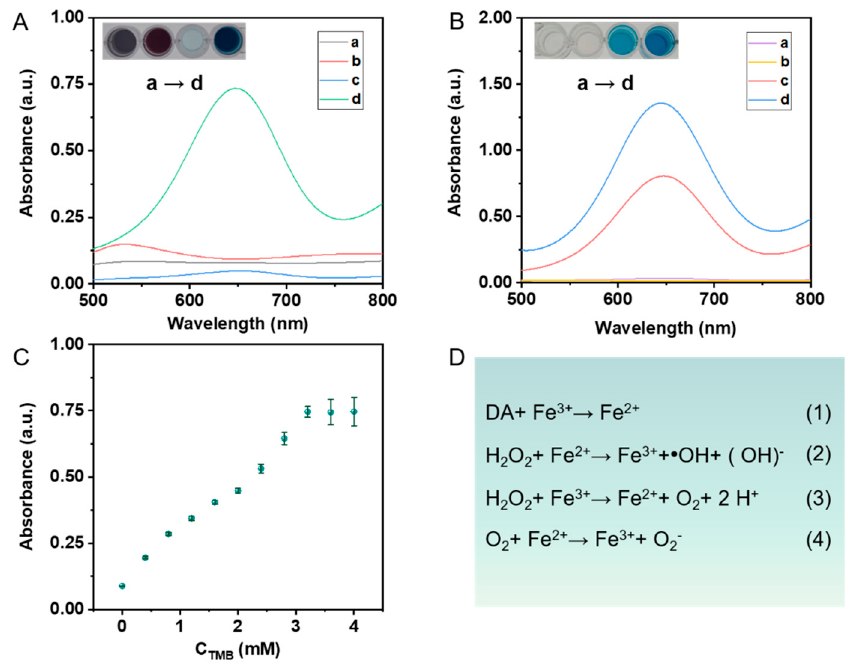
Figure 3. ( A ) UV-vis absorption spectral and color changes of the reaction systems: (a) without H 2 O 2 , (b) without TMB, (c) without nanoenzyme reactors, (d) nanoenzyme reactors-H 2 O 2 -TMB. ( B ) UV-vis absorption spectral response and color changes of the Fenton-like reaction: (a) without H 2 O 2 , (b) without TMB, (c) Fe 3+ -H 2 O 2 -TMB, (d) Fe 3+ -DA-H 2 O 2 -TMB. ( C ) The steady-state kinetic assay of Au@SNF NPs-catalyzed oxidation of TMB by H 2 O 2 . ( D ) The mechanism of the peroxidase-like catalytic ability with Au@SNF NPs.